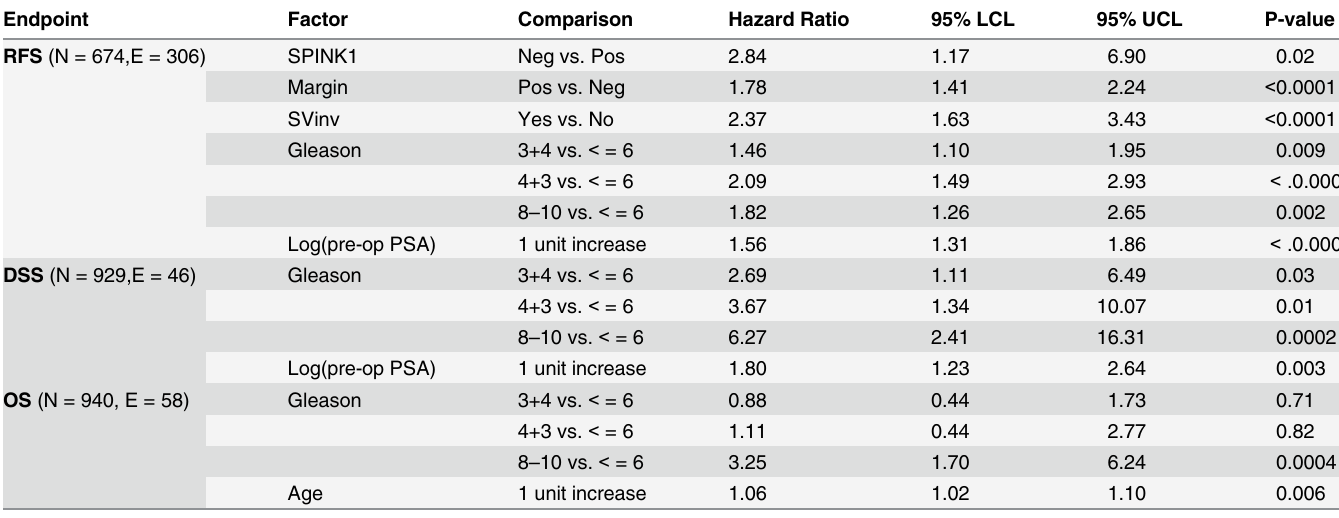
Table 4. Multivariate Cox proportional hazard